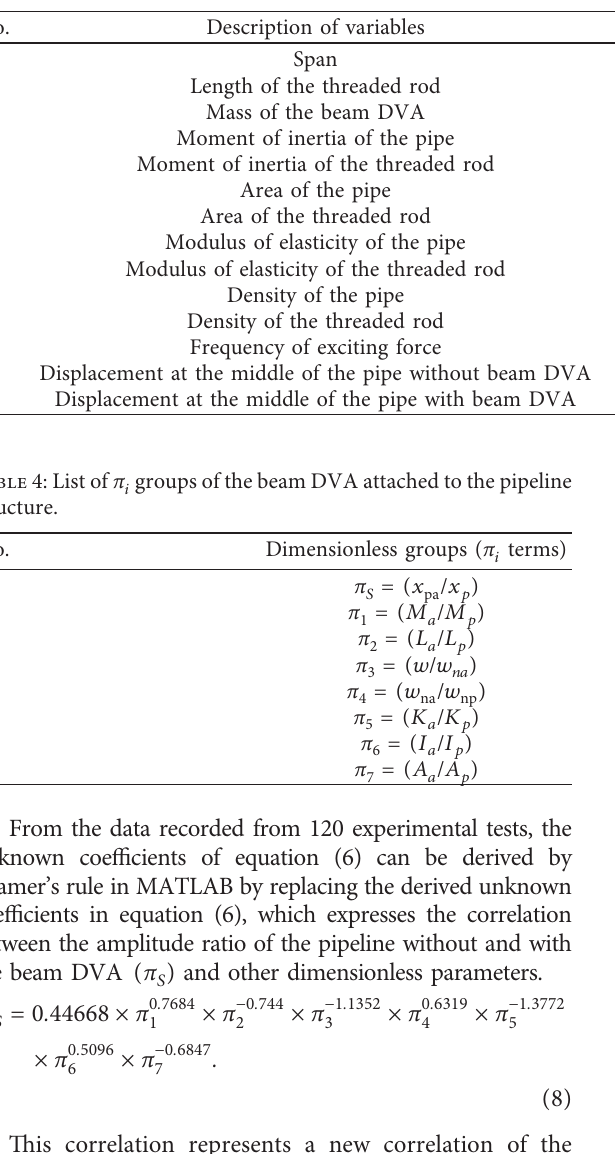
Table 3: List of variables and fundamental dimensions that affect the beam DVA attached to the pipeline structure. No.